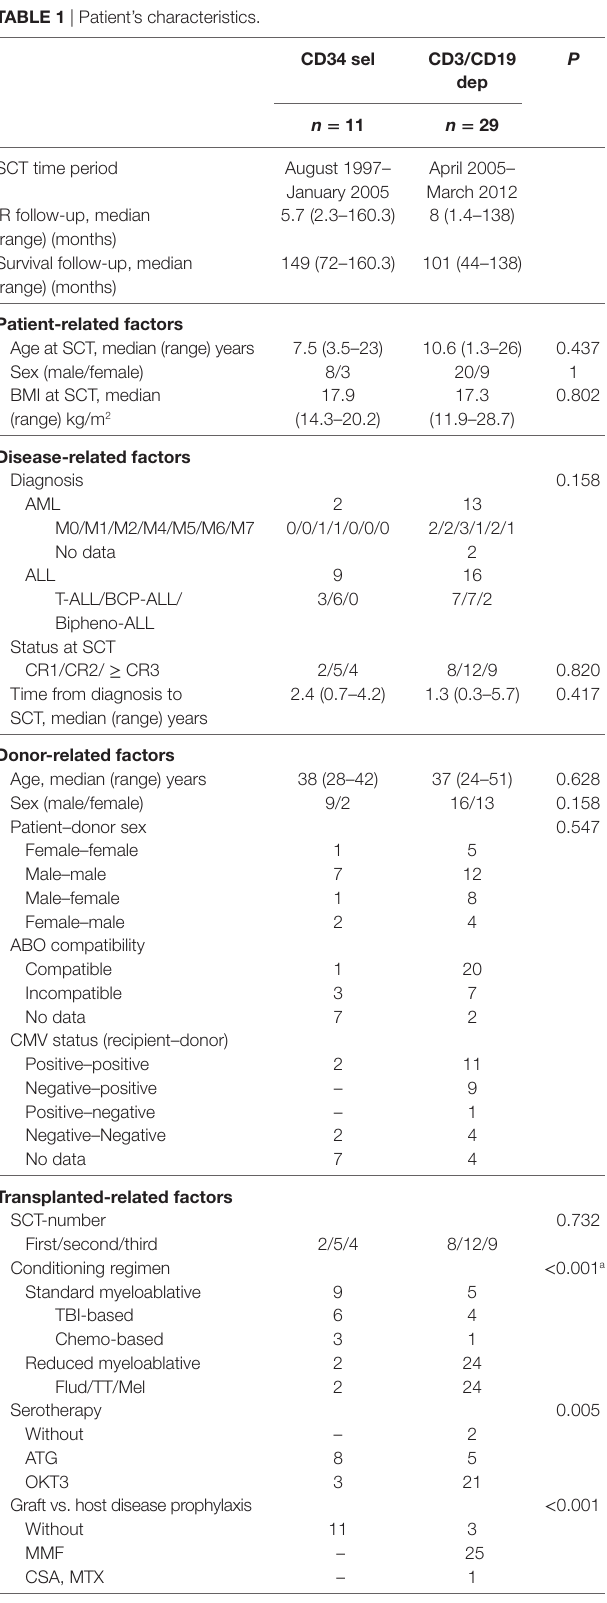
Table 1 | Patient’s